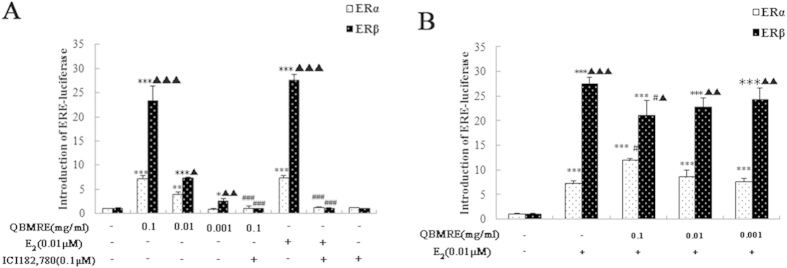
Activity of QiBaoMeiRan formula extract (QBMRE) on estrogen receptor (ER) α/β -estrogen response element (ERE) luciferases reporter gene expression.(A) The effect of QBMRE on ER α/β - ERE luciferases reporter gene expression in HEK293 cells. (B) The effect of the combination of QBMRE and E2 on ER α/β - ERE luciferases reporter gene expression in HEK293 cells. Data are the mean ± standard deviation of quadruplicate analyses, expressed relative to that of treatment with 0.1% DMSO. *p < 0.05, **p < 0.01 compared to DMSO; #p < 0.05, ###p < 0.001, compared to 0.01 μM E2. (▲▲▲) p < 0.001, (▲▲▲) p < 0.01, (▲) p < 0.05, compared with ERα-ERE luciferases reporter gene expression relative increase to Control.